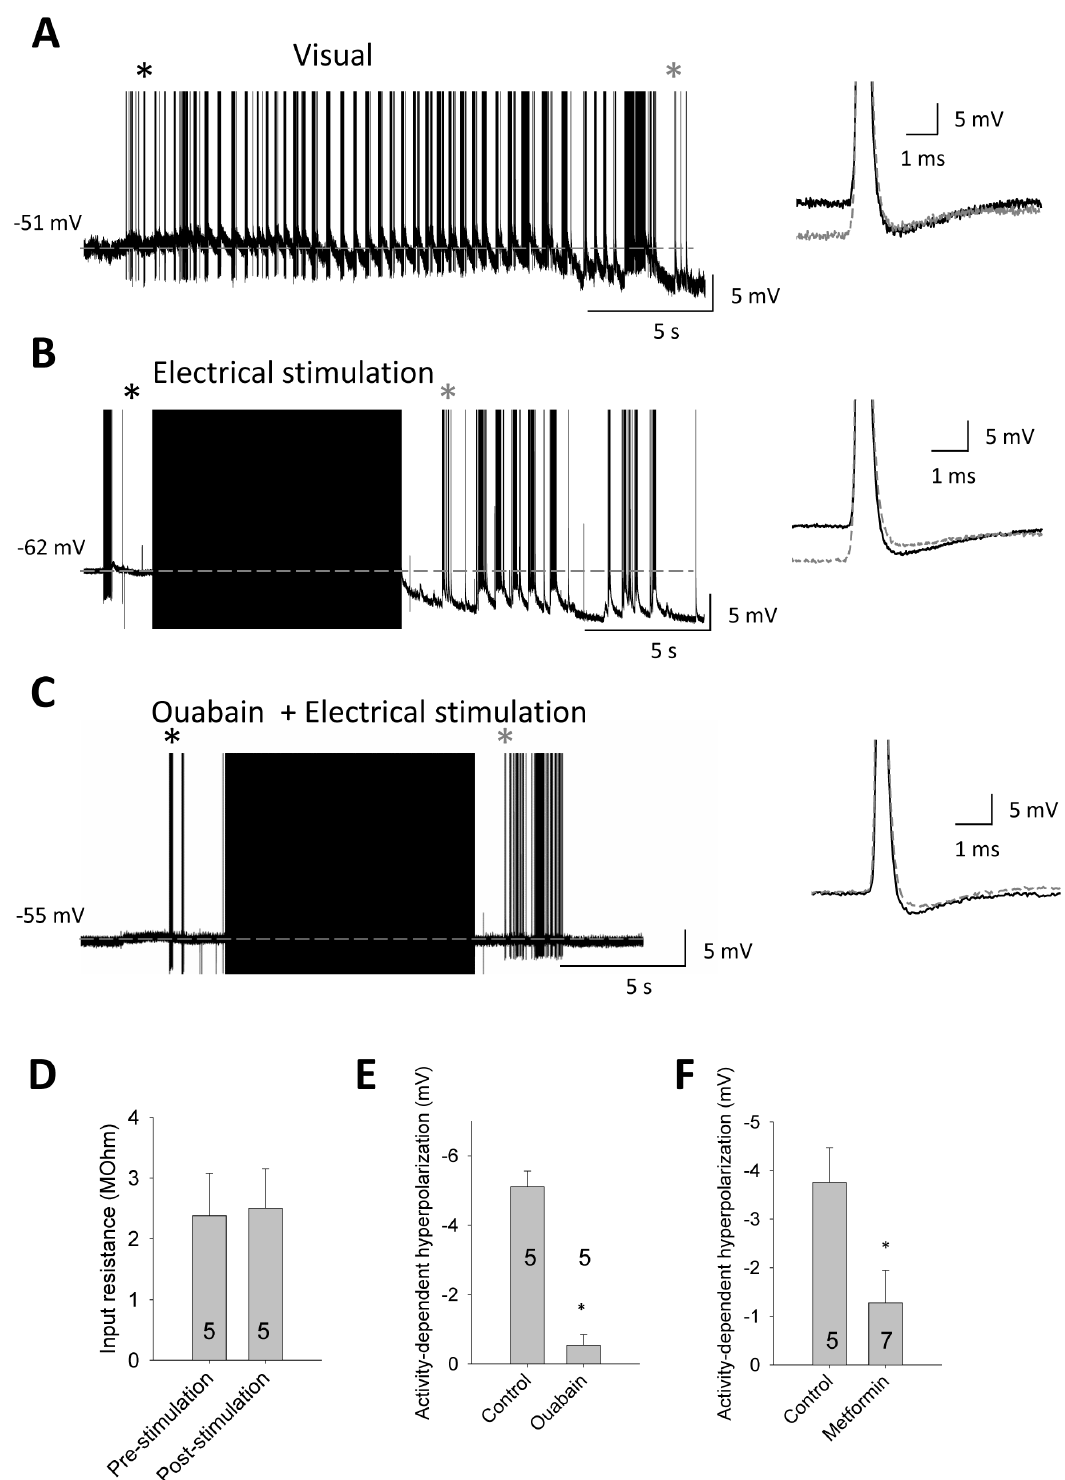
Figure 6. Loss of an activity-dependent hyperpolarization in the DCMD axon following AMPK pathway activation. ( A ). The DCMD axon hyperpolarizes during periods of high frequency activity in response to visual stimulation. The shift in membrane potential occurs with no change in the reversal of the afterpotential (side panel), suggesting that this is an electrogenic effect. Black and grey traces in right-side panel are from time points in raw trace indicated by black and grey asterisks, respectively. ( B ). The membrane potential shows similar hyperpolarizing shifts following electrical stimulation of the axon that generates APs. ( C ). Electrically stimulated activity fails to evoke a hyperpolarization during ouabain treatment (10 2 4 M). ( D ). There is no change in input resistance before the activity-dependent hyperpolarization (pre) compared to during the event (post). ( E ). This hyperpolarization is greatly reduced after ouabain application (10 2 4 M; P , 0.05). ( F ). Metformin (10 mM) significantly reduces the hyperpolarization in response to 100 Hz electrical stimulation (P , 0.05). doi:10.1371/journal.pone.0088570.g006 PLOS ONE |